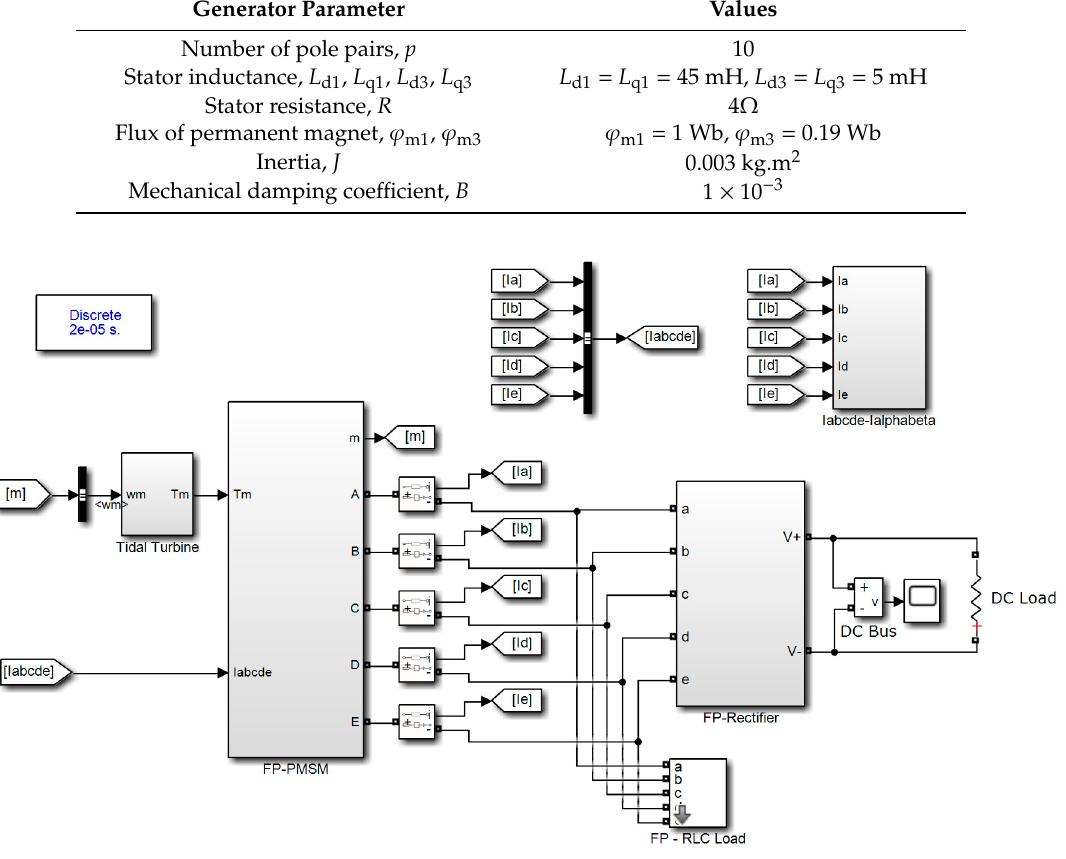
Figure 2. Simulation platform of the five-phase permanent magnet synchronous generator (FP-PMSG)-based direct-drive MCGS.